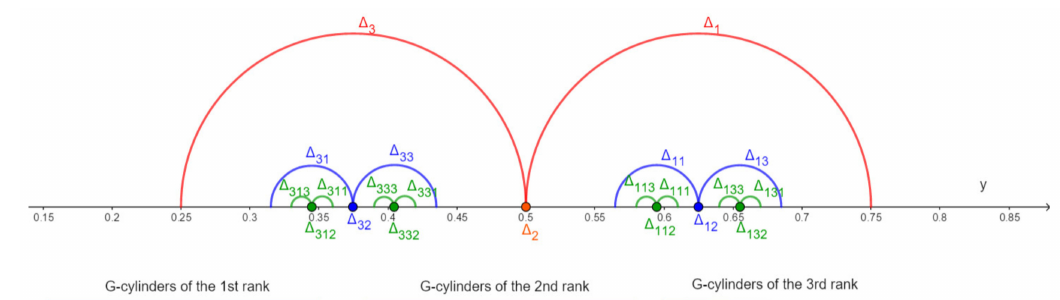
Figure 12. The image of the plural C 2 .